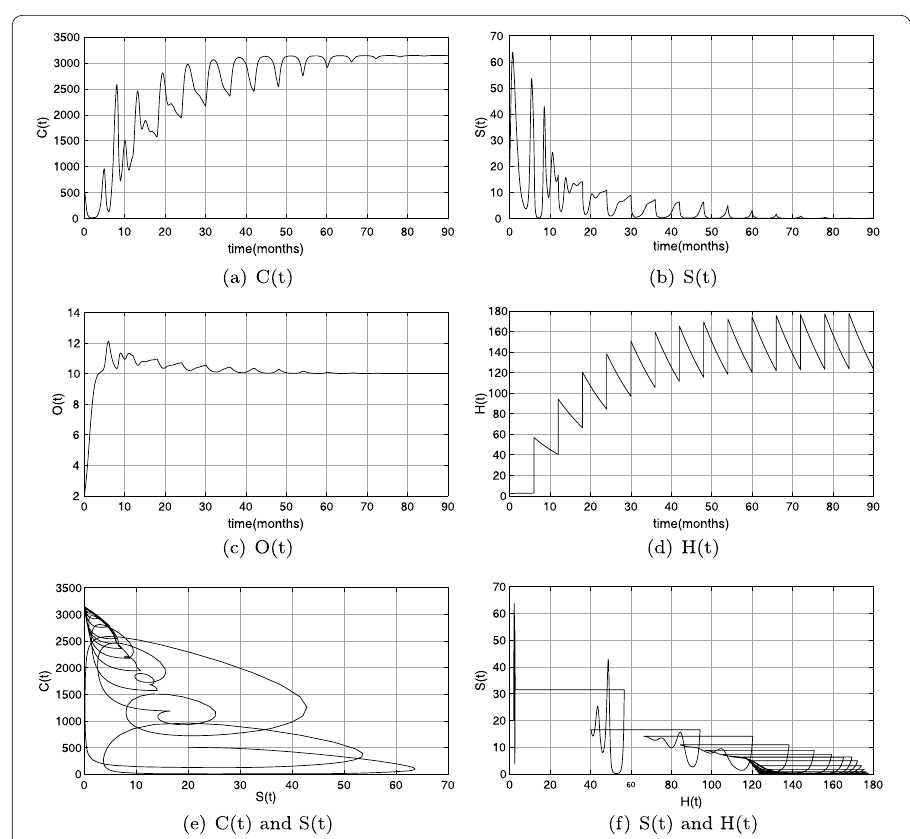
Figure 2 Strategy 2: C (0) = 500, S (0) = 20, O (0) = 2, H (0) = 2, h = 54, T = 6 ( a ) the dynamic of C ( t ), ( b ) the dynamic of S ( t ), ( c ) the dynamic of O ( t ), ( d ) the dynamic of H ( t ), ( e ) the dynamic of C ( t ) and S ( t ), ( f ) the dynamic of S ( t ) and H ( t